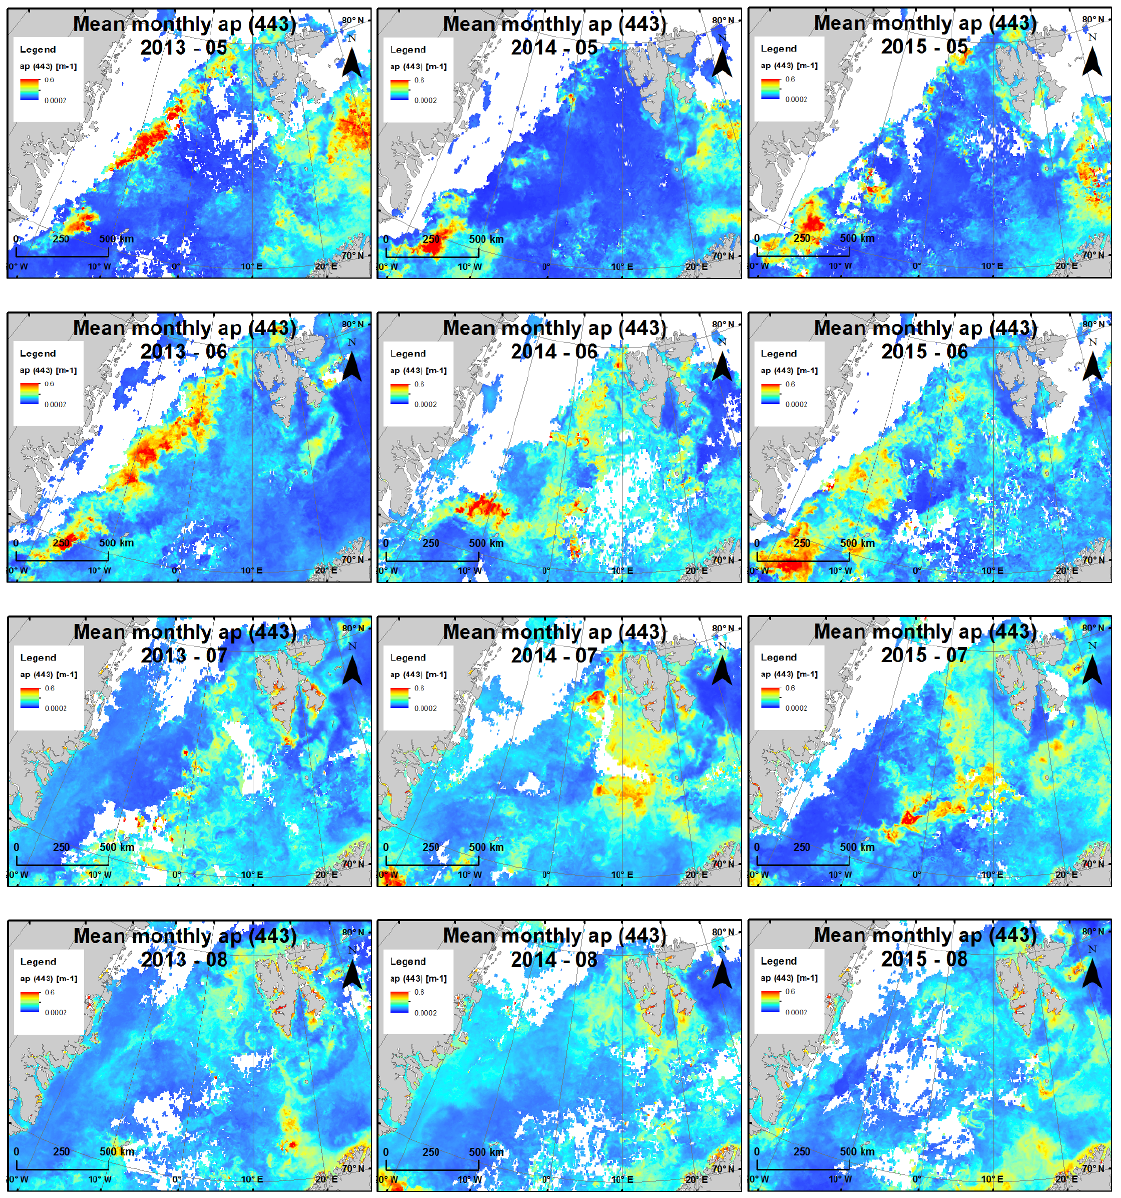
Figure 9. Mean monthly mosaics of absorption by particles at 443 nm computed on the basis of the proposed algorithm. ( Left ) to ( Right )—years: 2013, 2014, 2015. ( Top ) to ( Bottom )—months: May, June, July,